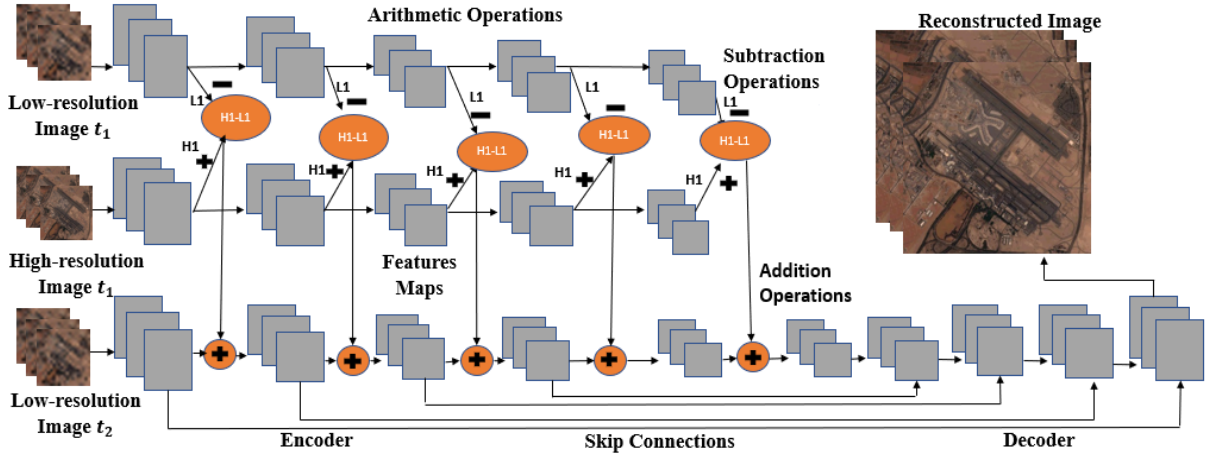
Figure 3. Proposed fusion model with the U-Net [33] backbone. In each of the convolutional feature maps, we subtract the low-resolution image’s features at t 1 (L1) from these extracted from the high- resolution image at t 1 (H1) and add these features computed from the low-resolution image at t 2 (L2) back into the feature maps to reconstruct the high-resolution image at t 2